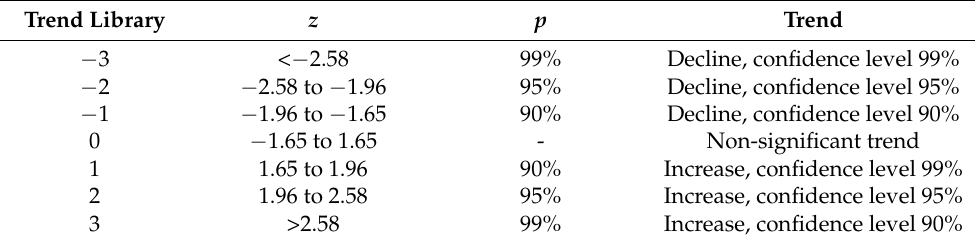
Table 1. Characteristics of trend of time